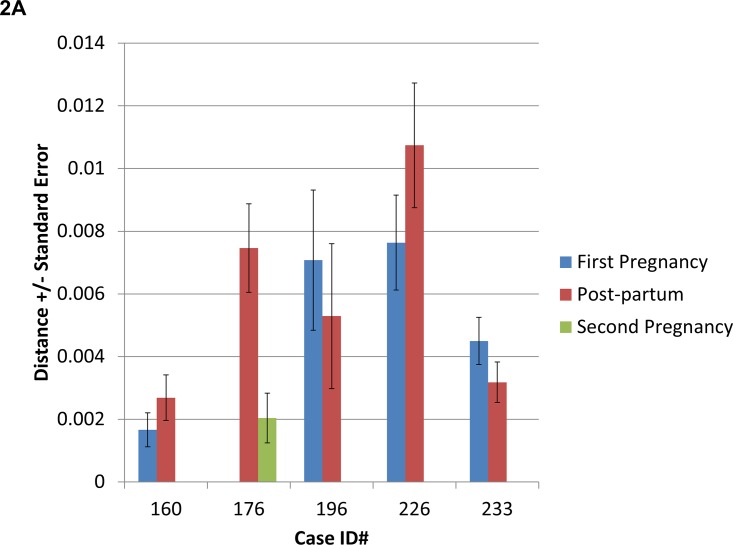
Comparison of distance amongst HBV quasispecies in patients during pregnancy and post-partum in pre-S/S (A, N = 5) and pre-C/C (B, N = 5) region. Measurement of distance within patient samples is shown and compared to measurement of distance within patient samples categorized by genotype. A comparison of relative evolutionary distances of patient samples collected at different time points is shown.Measurement of HBV distance within each individual sample is shown and compared to measurement of distance within individuals categorized by genotype. A comparison of relative evolutionary distances of HBV in each sample collected at different time points is shown.